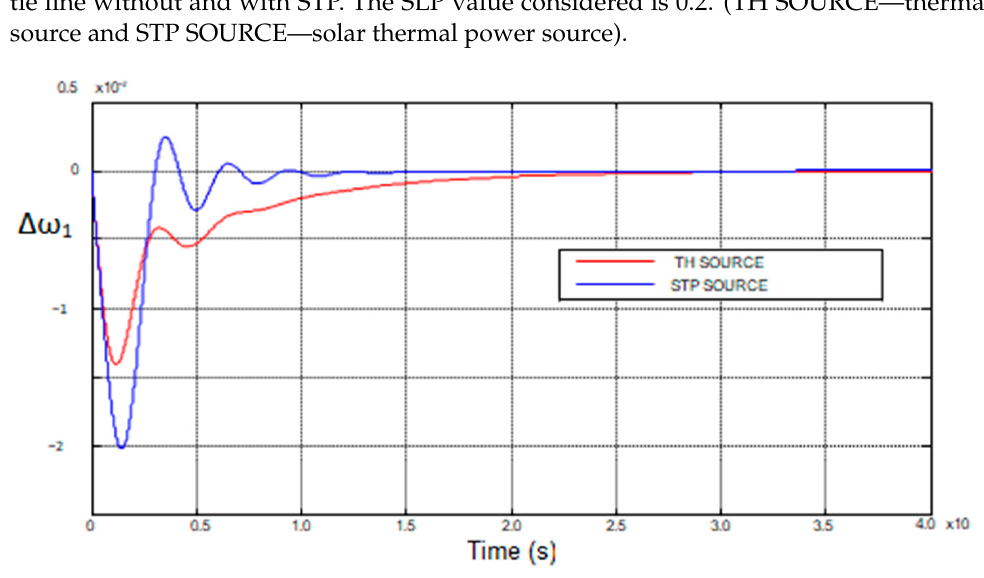
Figure 7. Changes in frequency in area 1 without and with STP (SLP two percent).